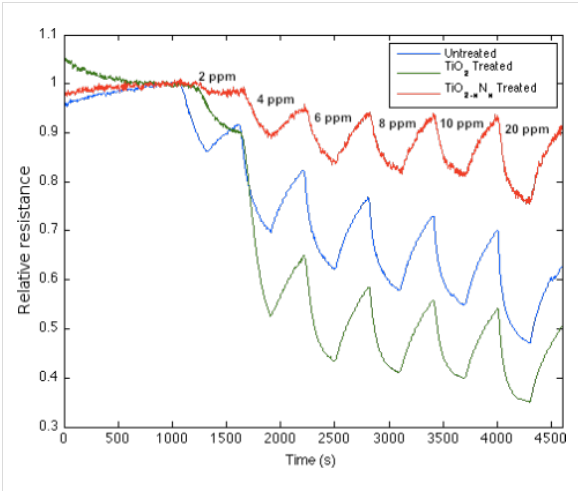
Figure 3: Response corresponding to decreasing resistance as NH 3 contributes electrons to an untreated porous silicon (PS), TiO 2 , and a